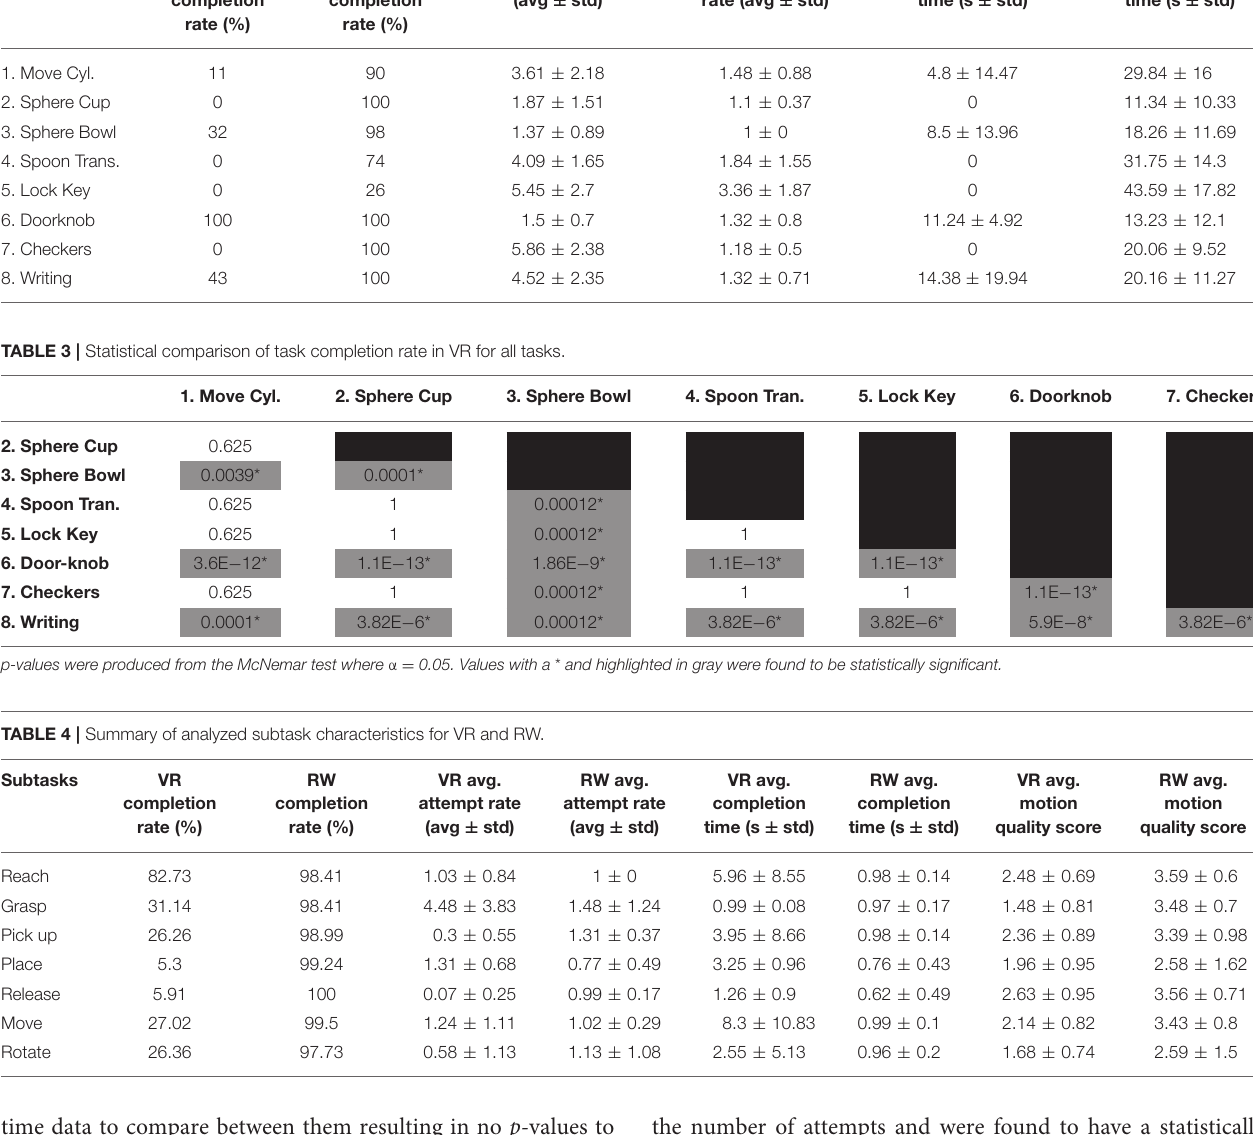
TABLE 2 | Summary of analyzed task characteristics for virtual reality (VR) and real world (RW). Tasks